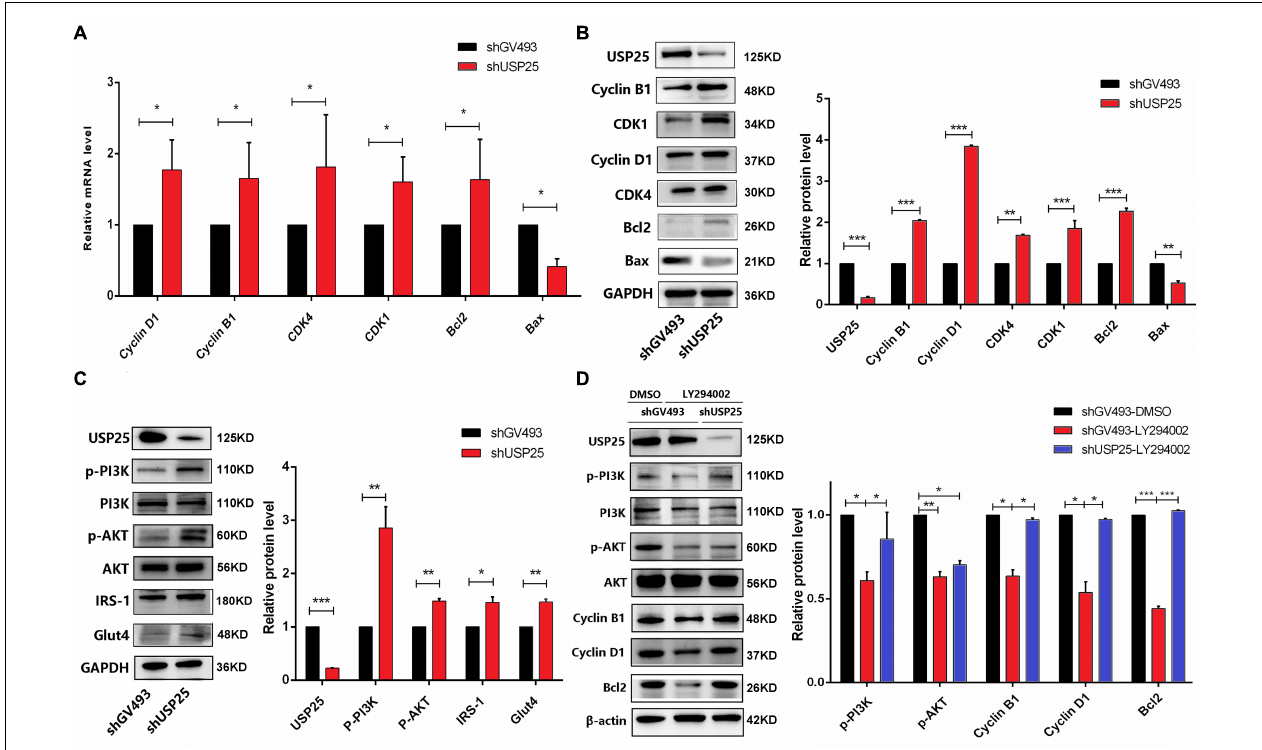
FIGURE 4 | USP25 regulated the proliferation and apoptosis of human ovarian GCs through the PI3K/AKT signaling pathway. (A) The expression of Cyclin D1, Cyclin B1, CDK4, CDK1, Bcl2, and Bax at the mRNA level. (B) Western blotting for USP25, Cyclin B1, CDK1, Cyclin D1, CDK4, Bcl2, and Bax analysis. Relative expression levels were normalized to that of GAPDH. (C) Western blot assays were conducted to detect the PI3K/AKT pathway and related proteins (USP25, PI3K, AKT, IRS-1, and Glut4). Relative p-PI3K and p-AKT expression levels were normalized to those of PI3K and AKT. The expression of USP25 and Glut4 was normalized to that of GAPDH. (D) Expression of PI3K/AKT pathway-related proteins after treatment with the specific inhibitor LY294002. Relative expression levels were normalized to that of β -actin. Relative p-PI3K and p-AKT expression levels were normalized to those of PI3K and AKT. In panels (A–D) , the data represents the mean ± SD. * P < 0.05, ** P < 0.01, *** P <